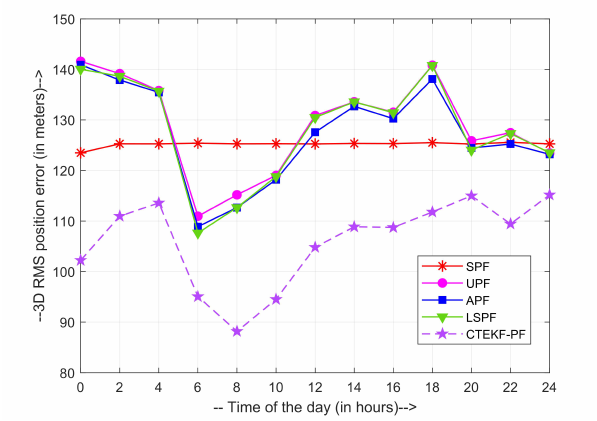
Fig. 2. Comparison of estimated 3D RMS position